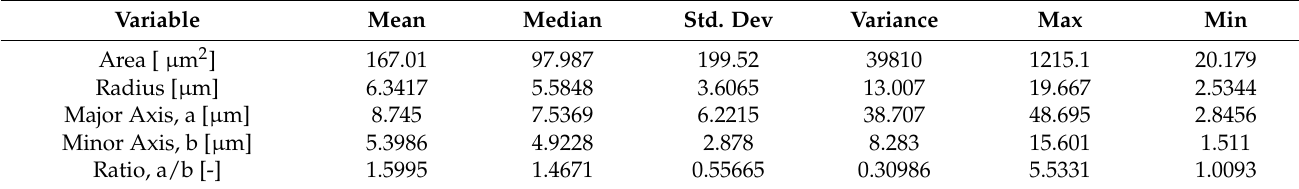
Table 16. Void data for Plate 1.